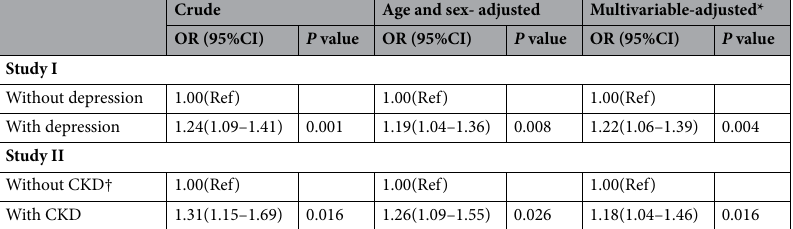
Table 2. Bidirectional association between depression and kidney disease. * Multivariable-adjusted for age, sex, living place, education level, smoking, drinking, body mass index, systolic blood pressure, and medical history (dyslipidemia, diabetes, cancer, heart disease, stroke, asthma, lung disease, liver disease, digestive disease, and memory problem). † CKD eGFR < 90 mL/min per 1.73 m 2 or with reported kidney diseases.